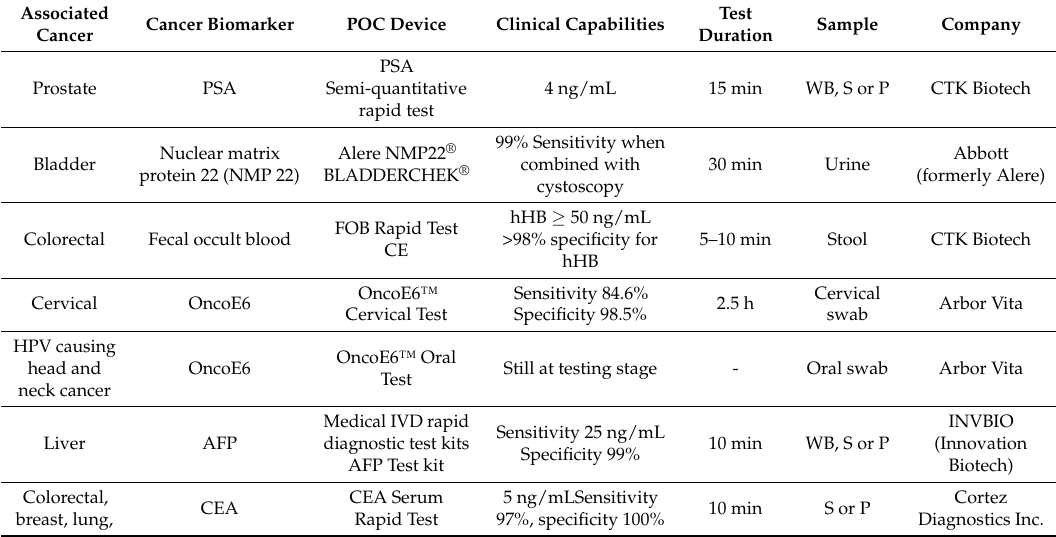
Table 2. Examples of commercially available POC devices for cancer detection. (Adapted from Sharma et al., 2015